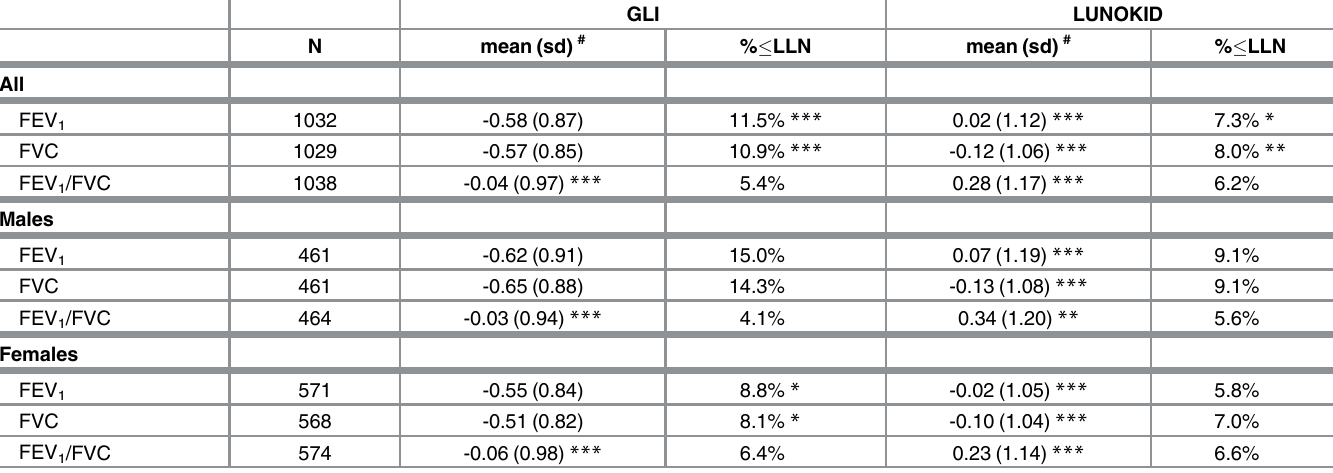
Table 4. GINIplus: GLI- and LUNOKID-based z-scores of all and of all male and female healthy participants.